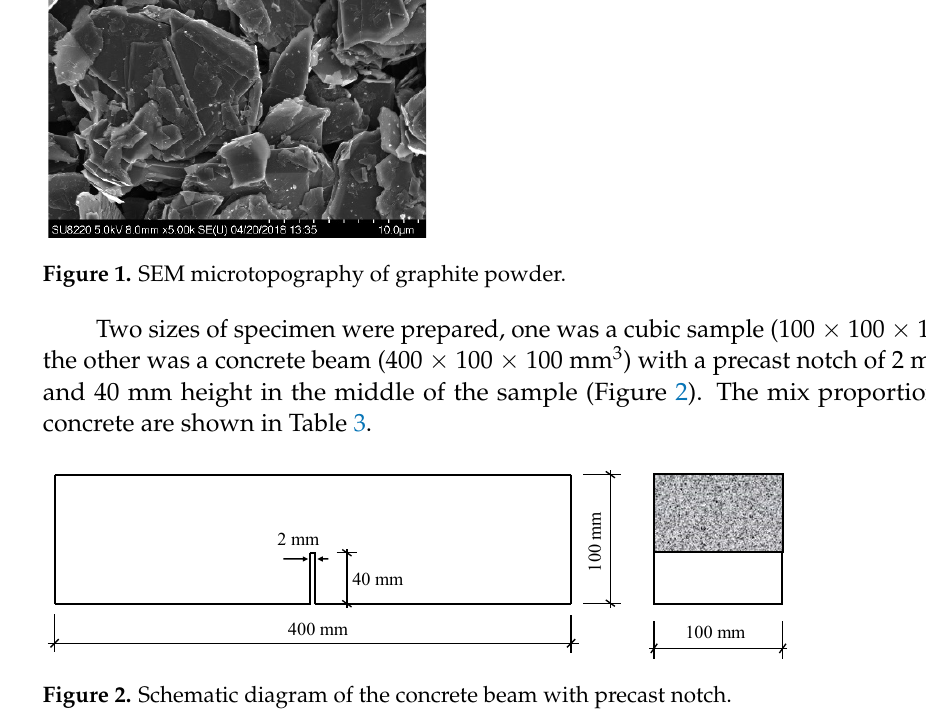
Figure 2. Schematic diagram of the concrete beam with precast notch. Table 3. Mix proportion of the concrete/kg/m 3